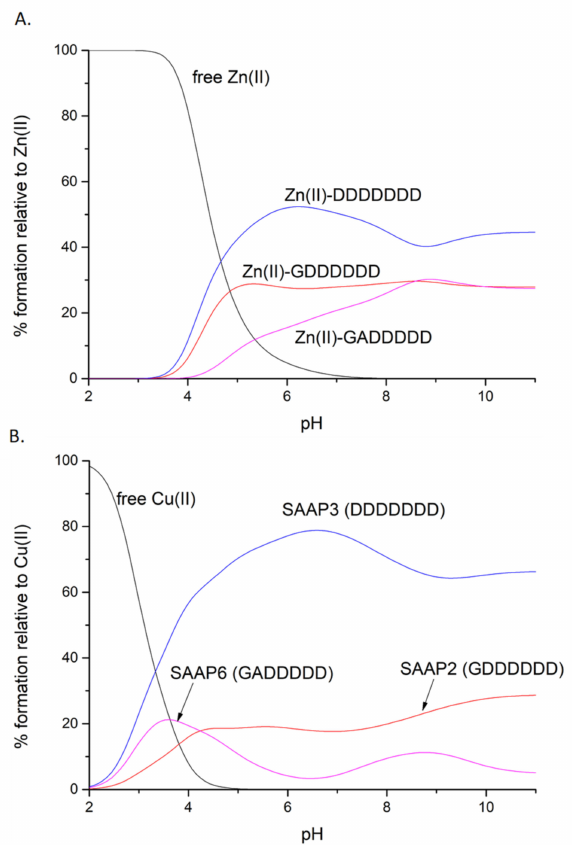
Figure 4. Competition plots for SAAP2, SAAP3, SAAP6, and Zn(II) ( A ) or Cu(II) ( B ), showing the relative amount of each complex at different pH values for the hypothetical situation in which equimolar amounts of the four species are